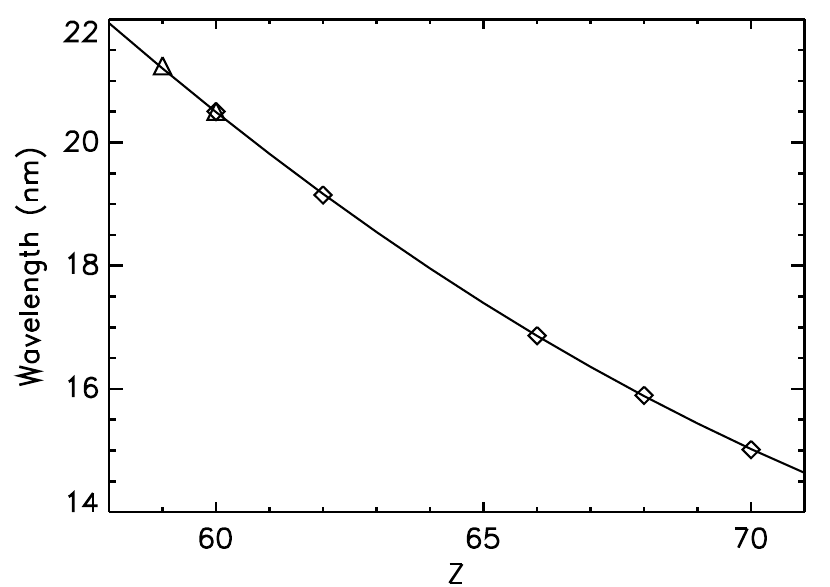
Figure 3. Z dependence of the wavelength for the transition 4s 2 4p [(4p + ) 3/2 ] − 4s4p 2 [((4s + ,4p − ) 1 ,4p + ) 5/2 ] of Ga-like ions. The line is a second order polynomial fitting of the EBIT data [6–10]. The wavelengths recorded in the NIST EBIT are plotted with diamonds, while those in LHD are plotted with triangles for Z = 59 and